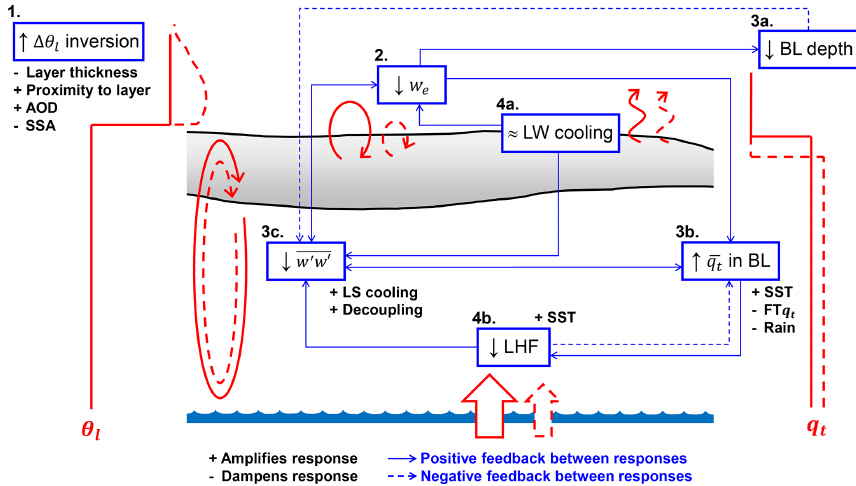
Figure 11. Summary of how the semi-direct effect manifests in a cross section of a stratocumulus-topped boundary layer. Solid red lines refer to the no-aerosol simulation and dashed red lines to the elevated absorbing aerosol layer simulations. Key responses to the boundary layer profiles are depicted in the blue boxes and include the strength of the inversion layer ( (cid:49)θ l inversion), entrainment rate ( w e ), boundary layer depth (BL depth), cloud-top longwave cooling (LW cooling), mean vertical motions in the boundary layer ( w (cid:48) w (cid:48) ), mean total water content of the BL ( q t ), and the latent heat flux at the ocean surface (LHF). Solid (dashed) arrows between boxes represent positive (negative) feedbacks between responses. For each response we include properties of the aerosol layer, boundary layer, or model setup that amplify (denoted by + ) or dampen (denoted by − ) the response; this includes the aerosol layer thickness (Layer thickness), cloud–aerosol gap (Proximity to layer), the aerosol optical depth of the layer (AOD), the single-scattering albedo of the aerosol layer (SSA), the sea surface temperature (SST), the water content of the free troposphere (FT q t ), precipitation (Rain), large-scale advective heat tendency (LS cooling), and the degree of boundary layer decoupling